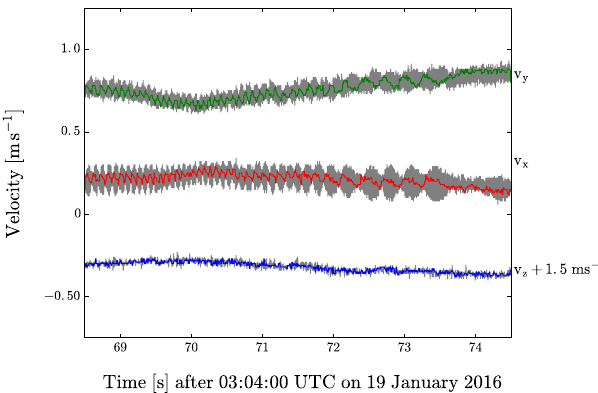
Figure 8. Plot of wind velocity, v , for a 6s portion of the period shown in Fig. 7. As in that figure, the raw 200Hz measurements are shown in gray, and the three-point median-filtered data are overplot- ted in color. A vertical offset has been added to the z component to remove excess